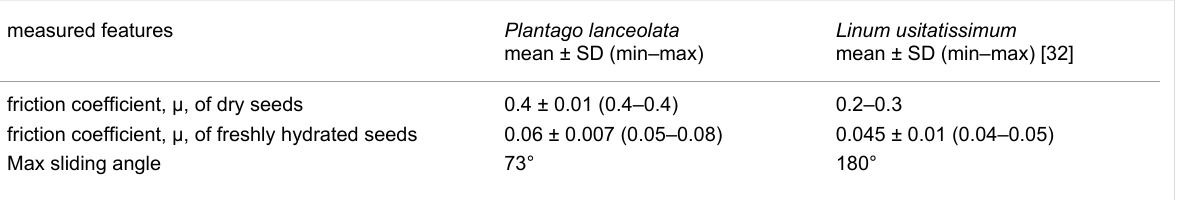
Table 4: Comparison of friction data for Plantago lanceolata (cellulose mucilage) and Linum usitatissimum (pectic mucilage). measured